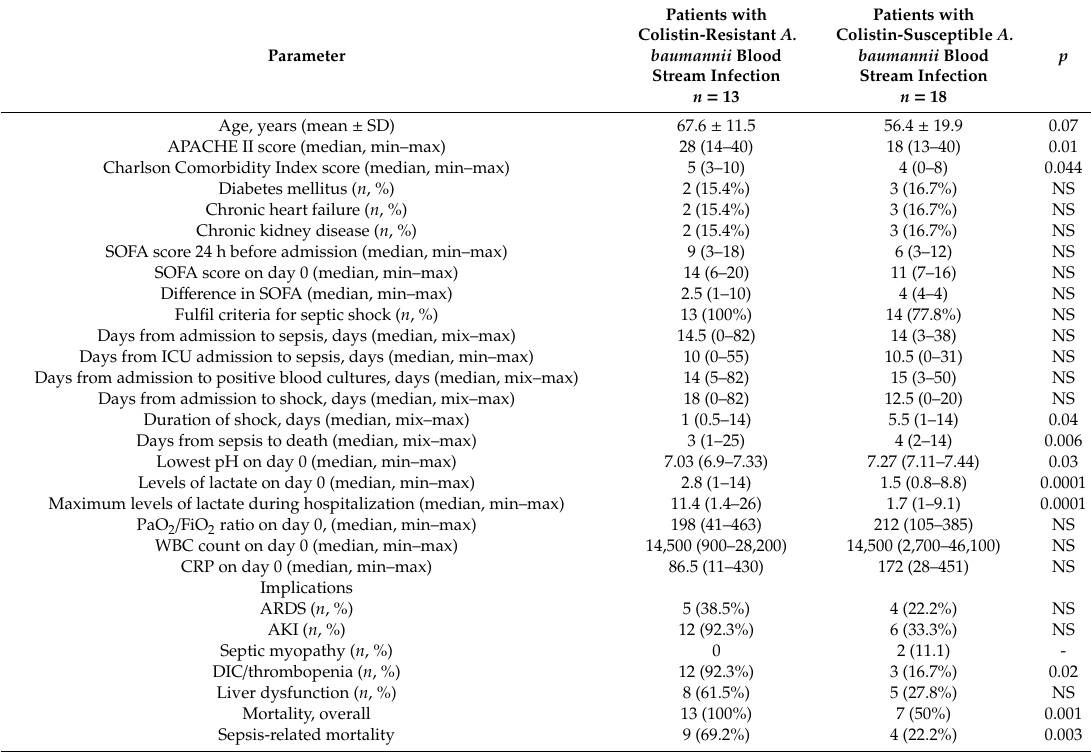
Table 3. Comparison between patients with colistin-resistant and colistin-sensitive A. baumannii bloodstream infection.